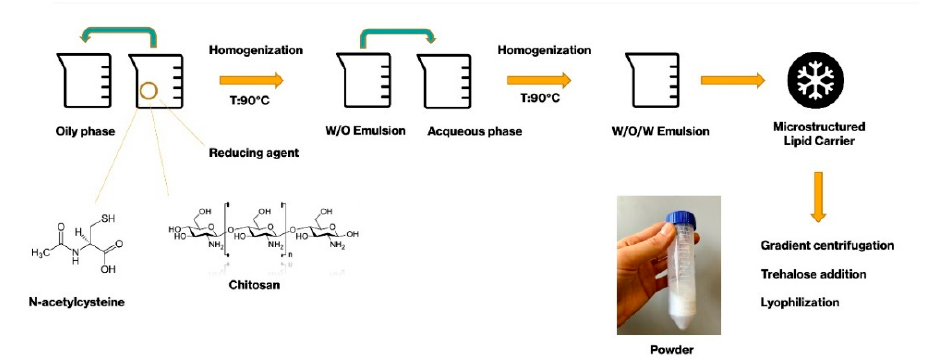
Figure 10. MLC preparation schematic procedure.